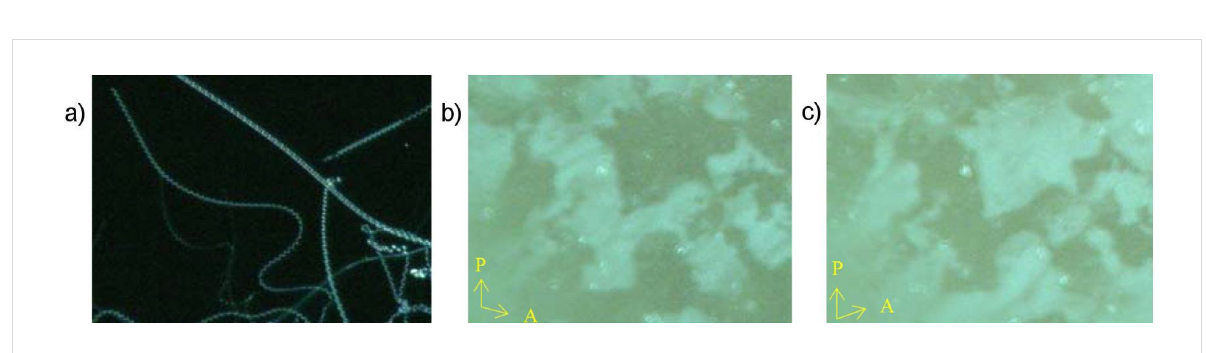
Figure 21: X-ray diffraction patterns of compounds OH 5 : a) Pattern of a powderlike sample of compound OH 5g at 150 °C on cooling (inset: small- angle region); b) small-angle pattern of OH 5g showing the reciprocal 2D lattice and the indexing of the observed reflections; c) small-angle pattern of a partially surface-aligned sample of compound OH 5f at 158 °C on cooling, showing the two preferred orientations of the reciprocal 2D lattice in the sample and the indexing of the observed reflections.